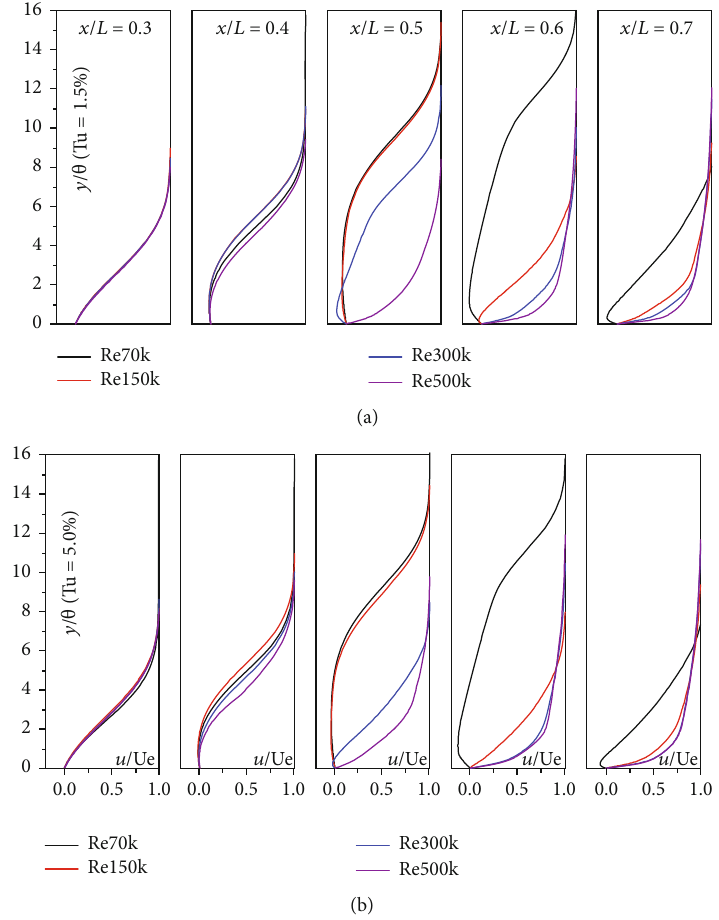
Figure 11: Velocity pro fi le comparison with fi xed Tu. (a) Tu=1.5%. (b) Tu=5.0%.